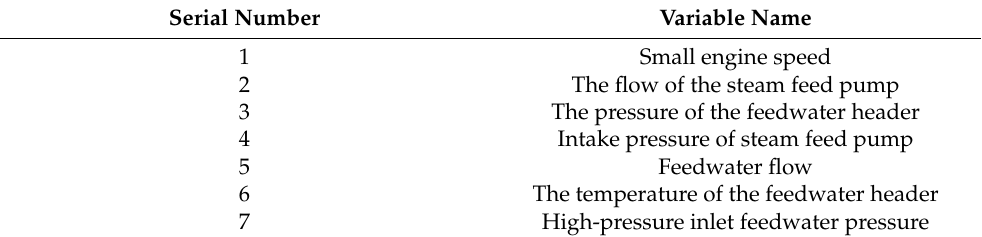
Table 3. Seven variables included in the steam feed pump system.